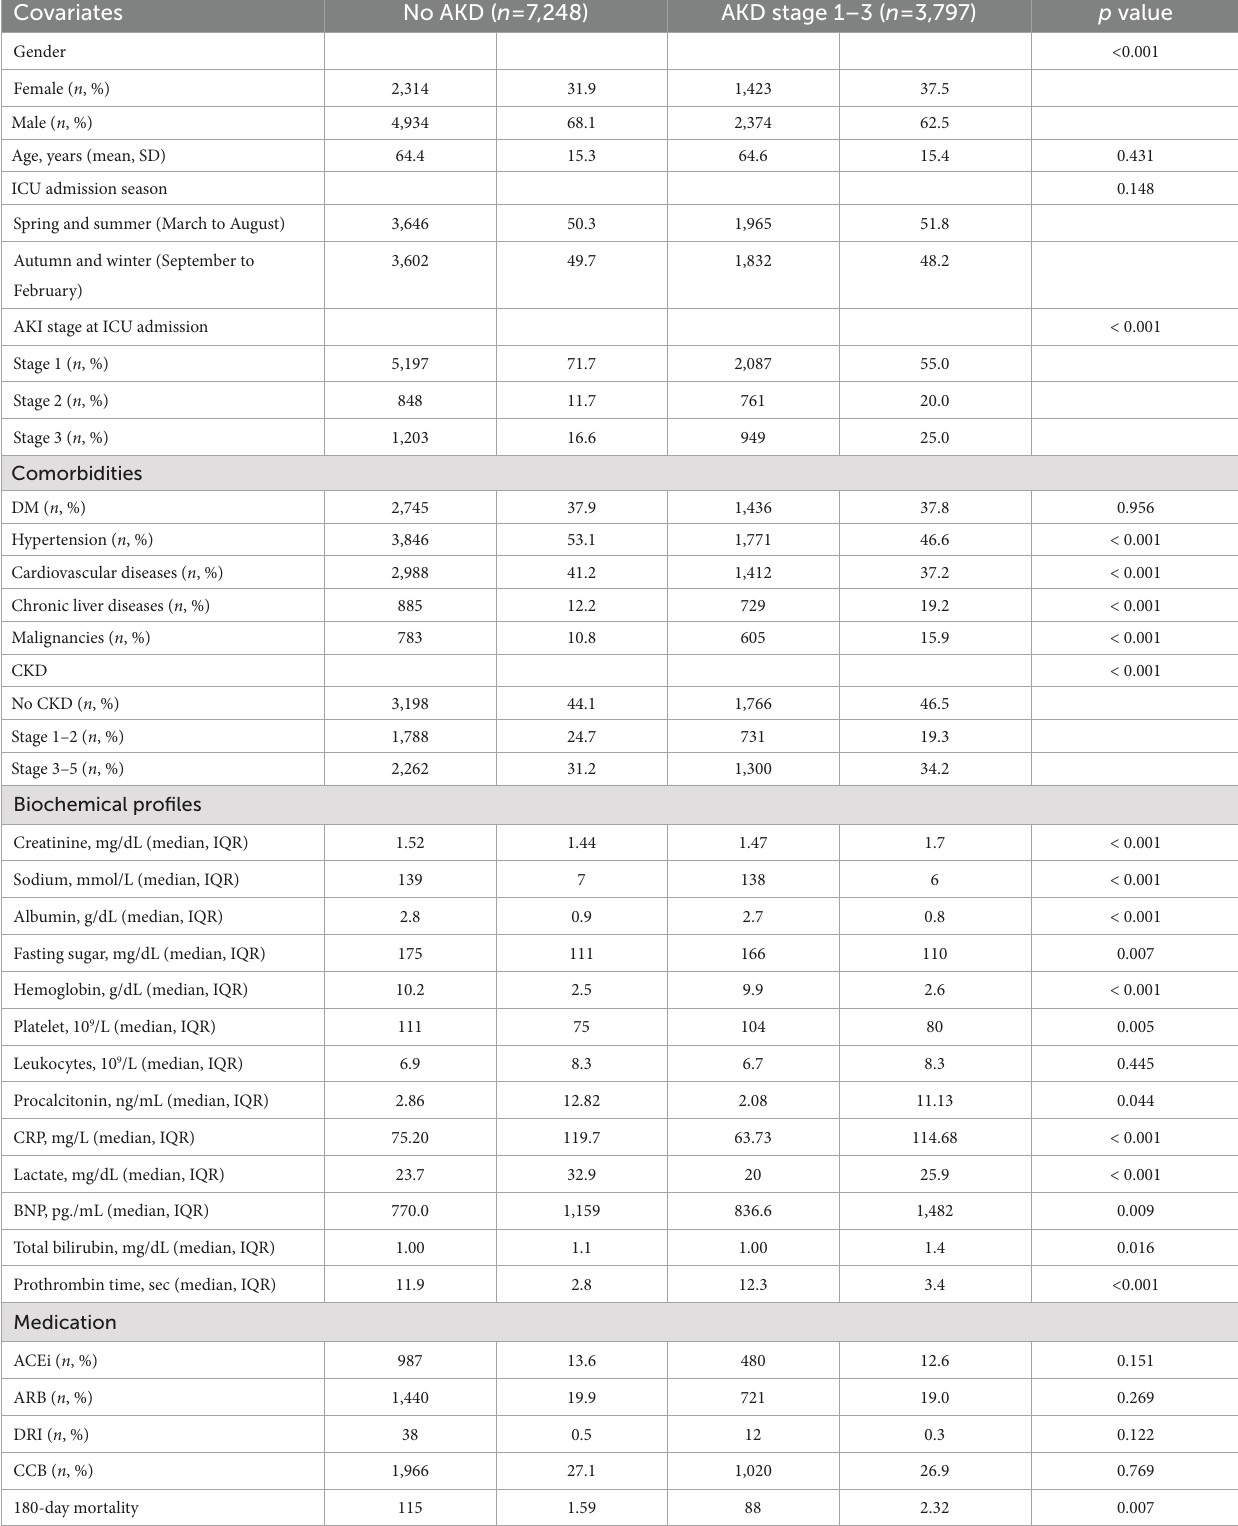
TABLE 1 Demographic characteristics of AKI patients with or without AKD upon ICU admission. Covariates No AKD ( n = 7,248) AKD stage 1–3 ( n = 3,797) p value